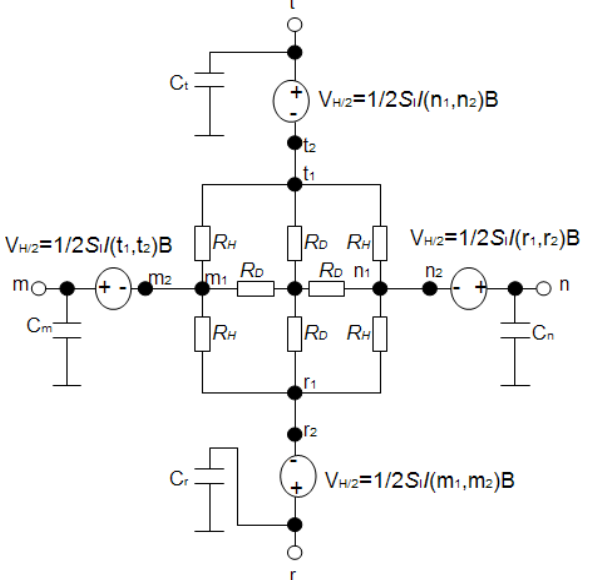
Figure 4. A simplified model for the CMOS integrated cross-shaped Hall